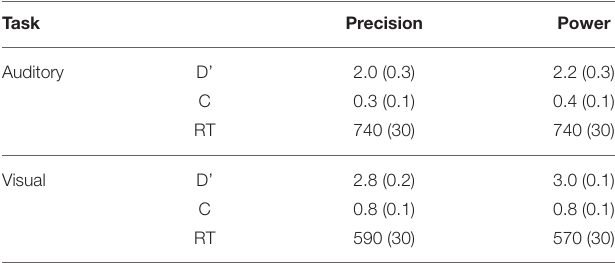
TABLE 1 | Mean (SEM) d’, C, and RT in auditory task and visual tasks.